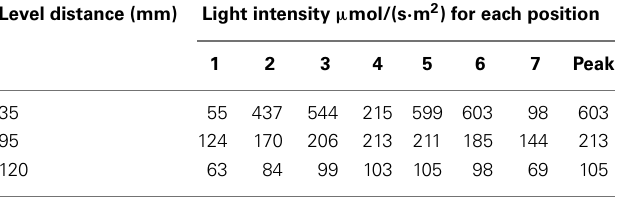
Table 2 | Light intensity levels inside the reactor